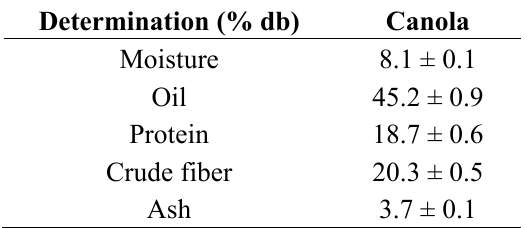
Table 1. Characterization of canola seeds (Barrel